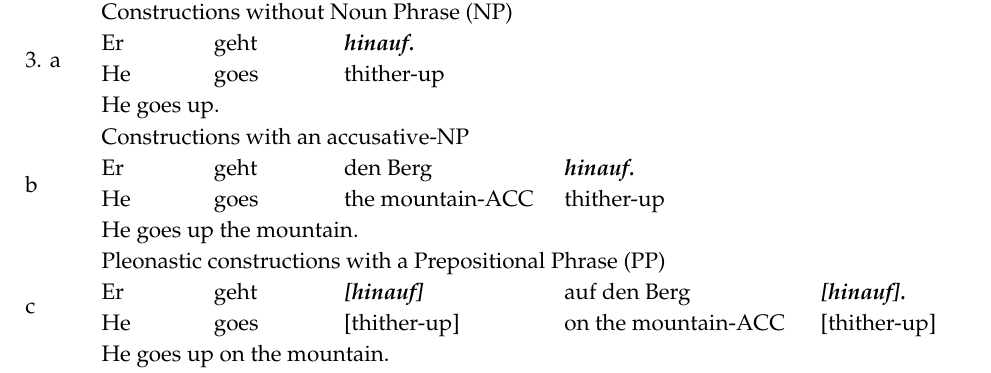
FIGURE MOTION / PATH GROUND MANNER A garrafa entrou na caverna (a flutuar) 1 The bottle went-in in-the cave (to-float) The bottle floated into the